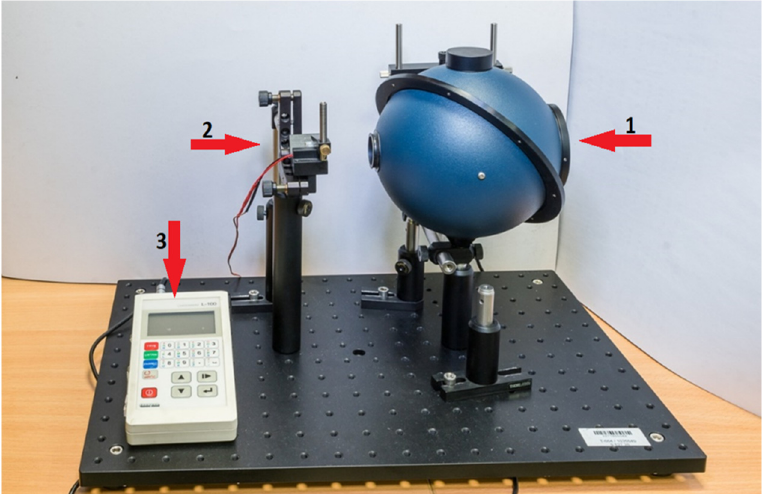
Figure 2. The experimental setup utilized in this study, where: 1 — integrating sphere, 2 — light source, 3 — luxmeter.